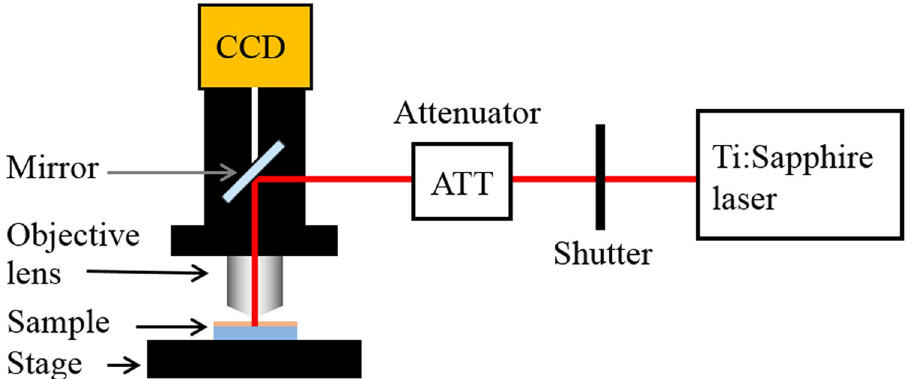
Figure 1. Schematic apparatus of the DLW system.